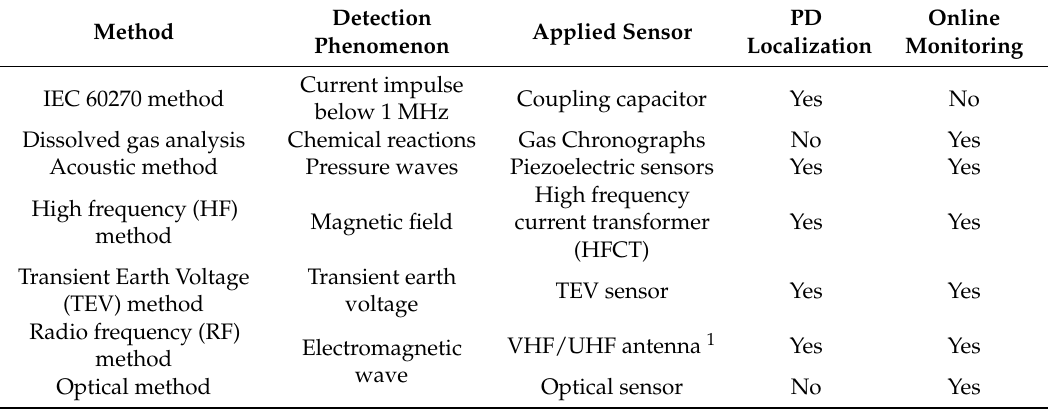
Table 1. Partial discharge (PD) detection